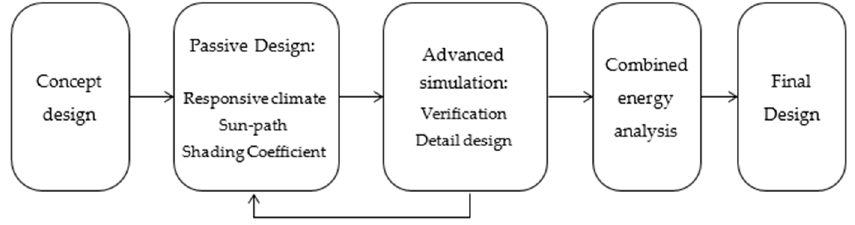
Figure 1. Schematic flowchart showing the process for calculating daylighting levels of a building.